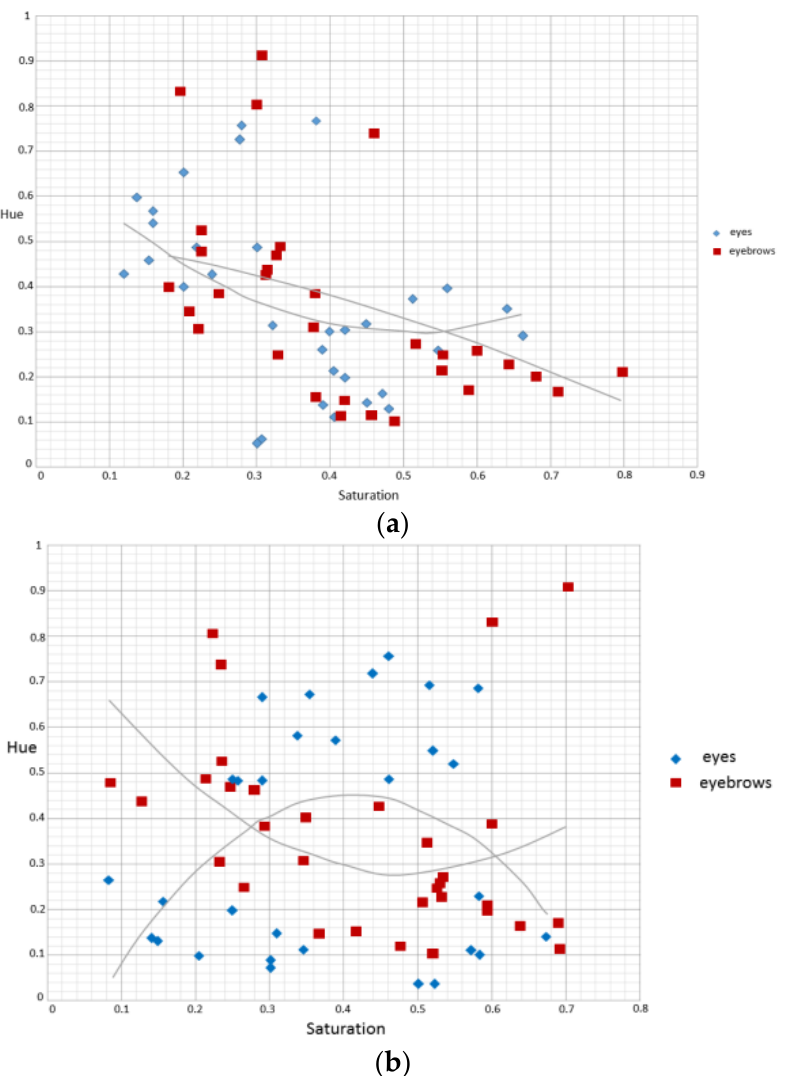
Figure 10. The relation between the saturation and the average hue of the authentic image (left) and the spoofed image (right) using eyes (blue) and eyebrows (red) as examples. ( a ) authentic image; and ( b ) spoofed image.